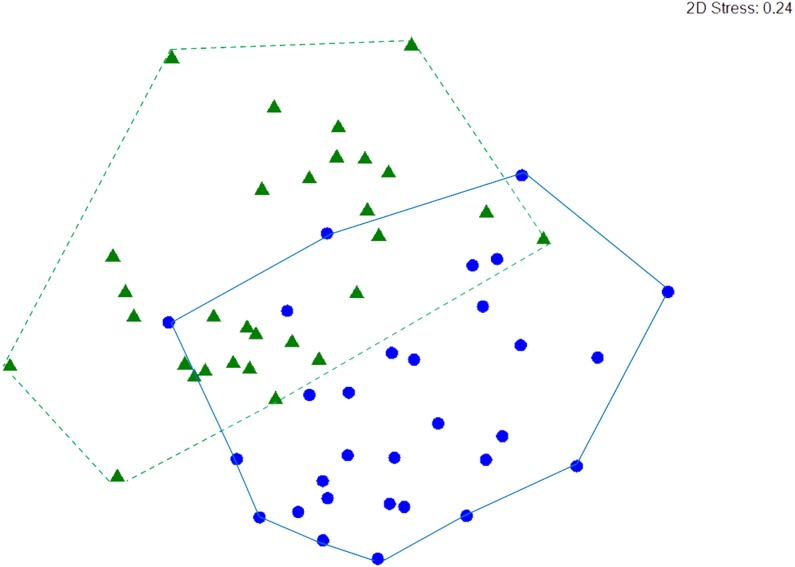
nMDS ordination.Non-metric multidimensional (nMDS) ordination of macrocrustacean community structure in samples from Limones reef (green triangles and dashed lines) and Bonanza reef (blue circles and continuous lines), based on species abundances. Each symbol denotes a transect.